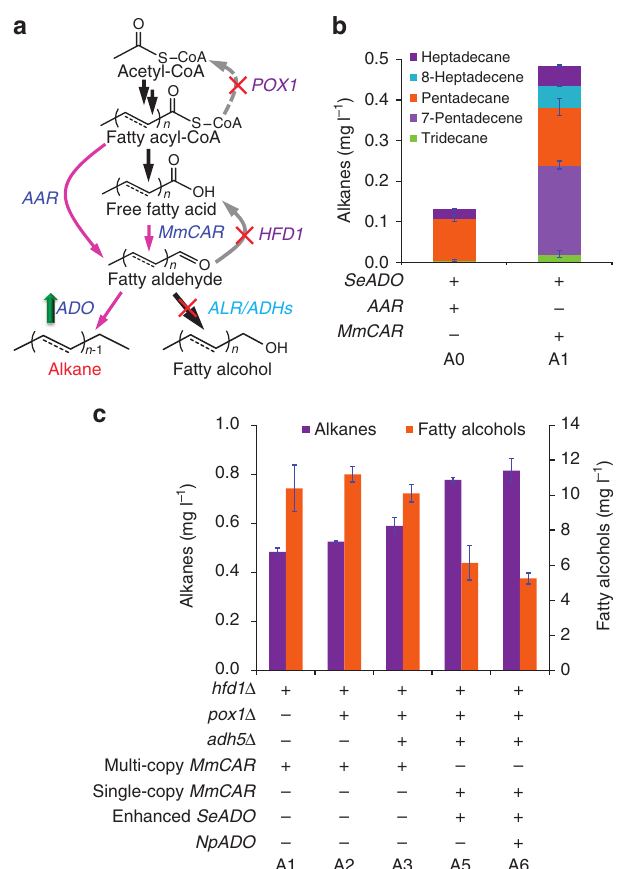
Figure 4 | Alkane production from FFAs. ( a ) The rewired metabolic pathways for enhancing alkane biosynthesis and decreasing accumulation of the by-product fatty alcohols. The alkane pathways are shown with pink arrows. ( b ) Alkane production by the FFA-derived (CAR and ADO) or the fatty acyl-CoA-derived (AAR and ADO) pathway. ( c ) Stepwise increasing alkane titres by eliminating competing pathways of aldehyde reduction and enhancing ADO expression, and corresponding fatty alcohol accumulation is also showed. The strains were cultivated in shake flasks for 72h at 200r.p.m., 30 (cid:2) C. All data represent the mean ± s.d. of biological